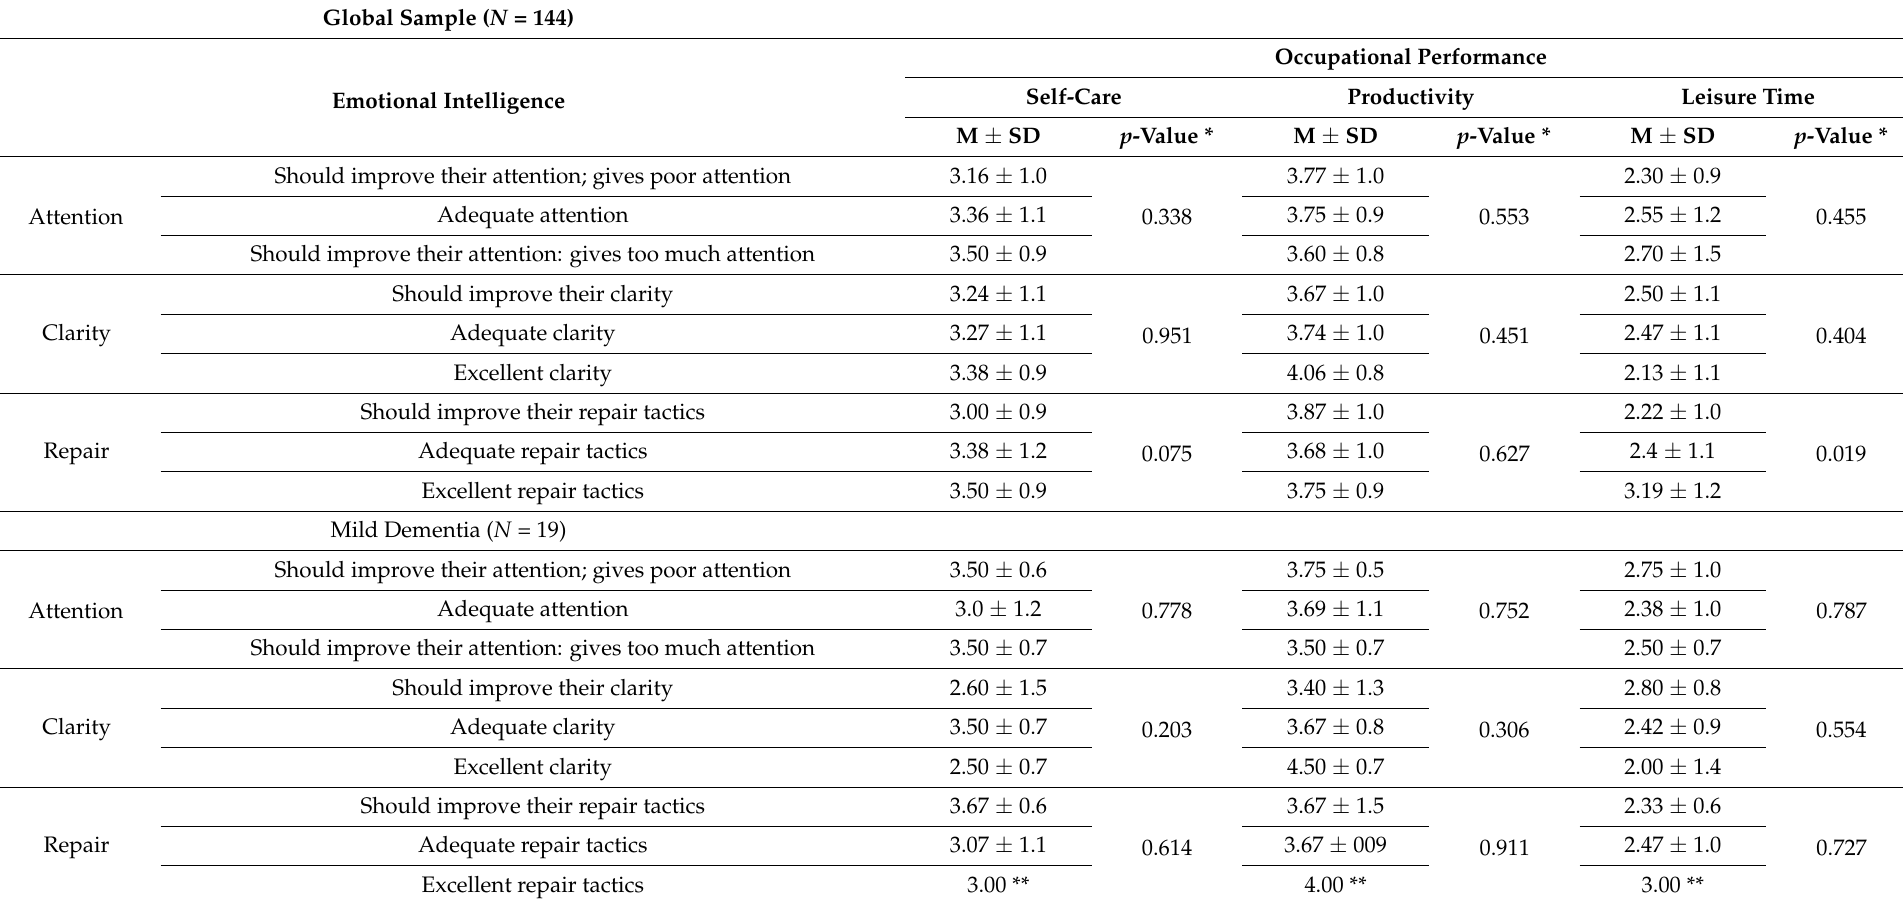
Table 6. Relationship between the subscales of emotional intelligence and occupational performance in caregivers of patients with dementia. Global sample and differentiation according to the patient’s dementia